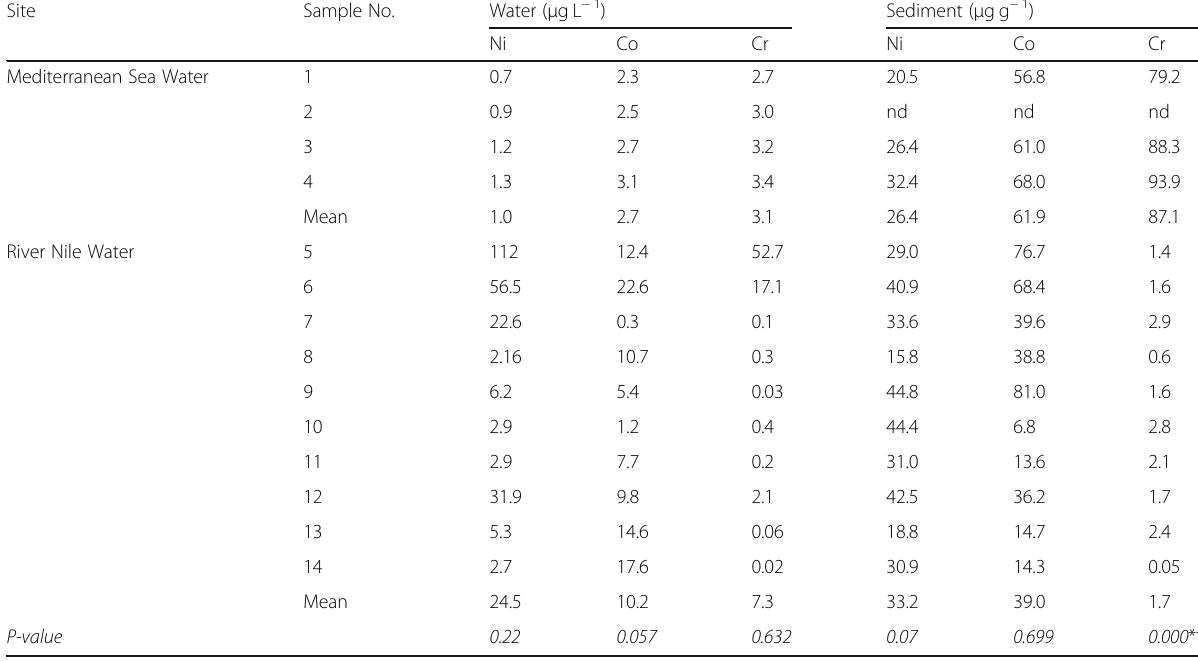
Table 1 Concentrations of heavy metals in water and sediment of freshwater and Seawater & One-way ANOVA between mean values of both environments Site Sample